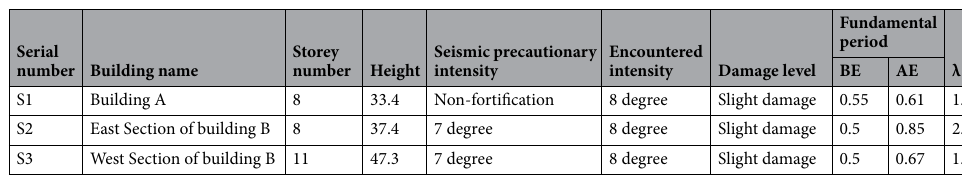
Table 3. Overview of two buildings in Tianjin, China.